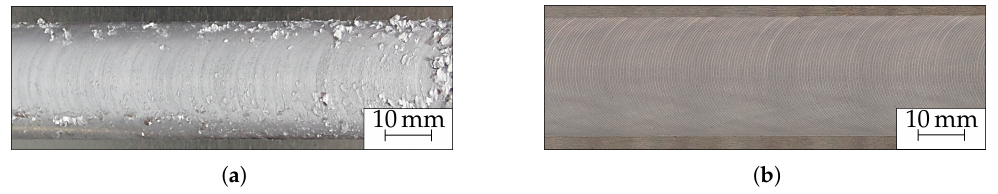
Figure 9. Comparison of the friction tracks (25mm in width) between the aluminum alloy EN AW- 2024-T3 ( a ) processed with parameter set III-PSb and EN AW-6082-T6 ( b ) produced with parameter set